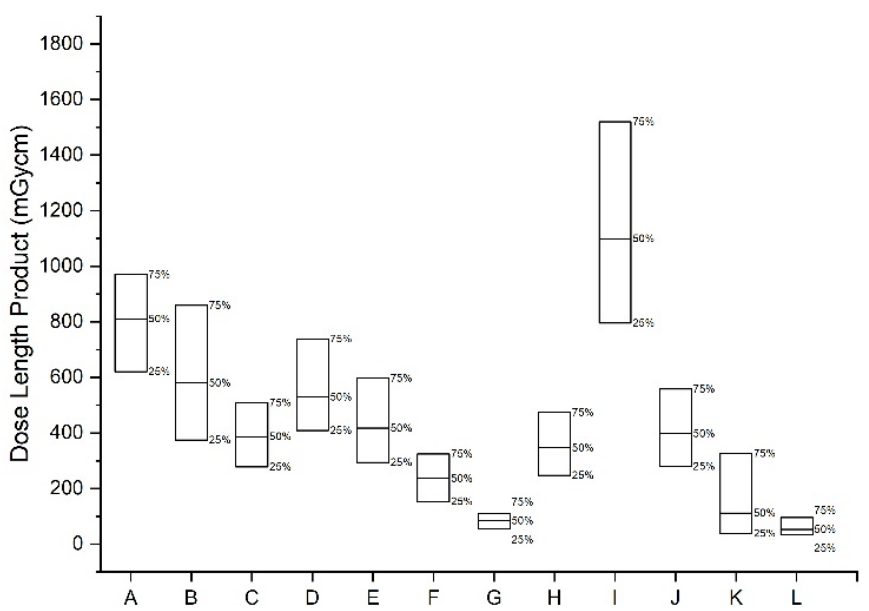
pelvis CT with contrast, I: Abdomen 4 phase dynamic CT with contrast, J: Abdomen-pelvis CT with-